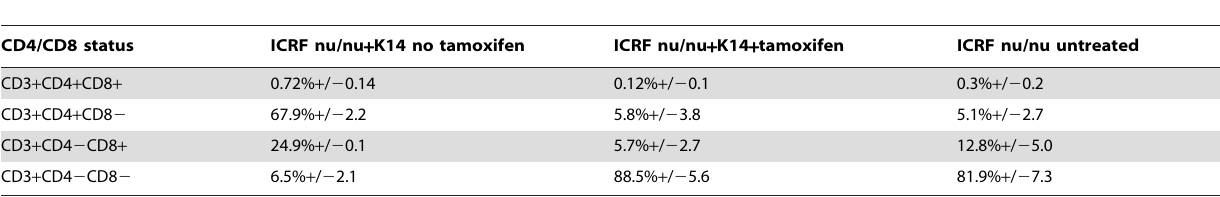
Table 1. Proportions of CD3 and CD4 positive cells in the spleens of transplanted NOD/SCID